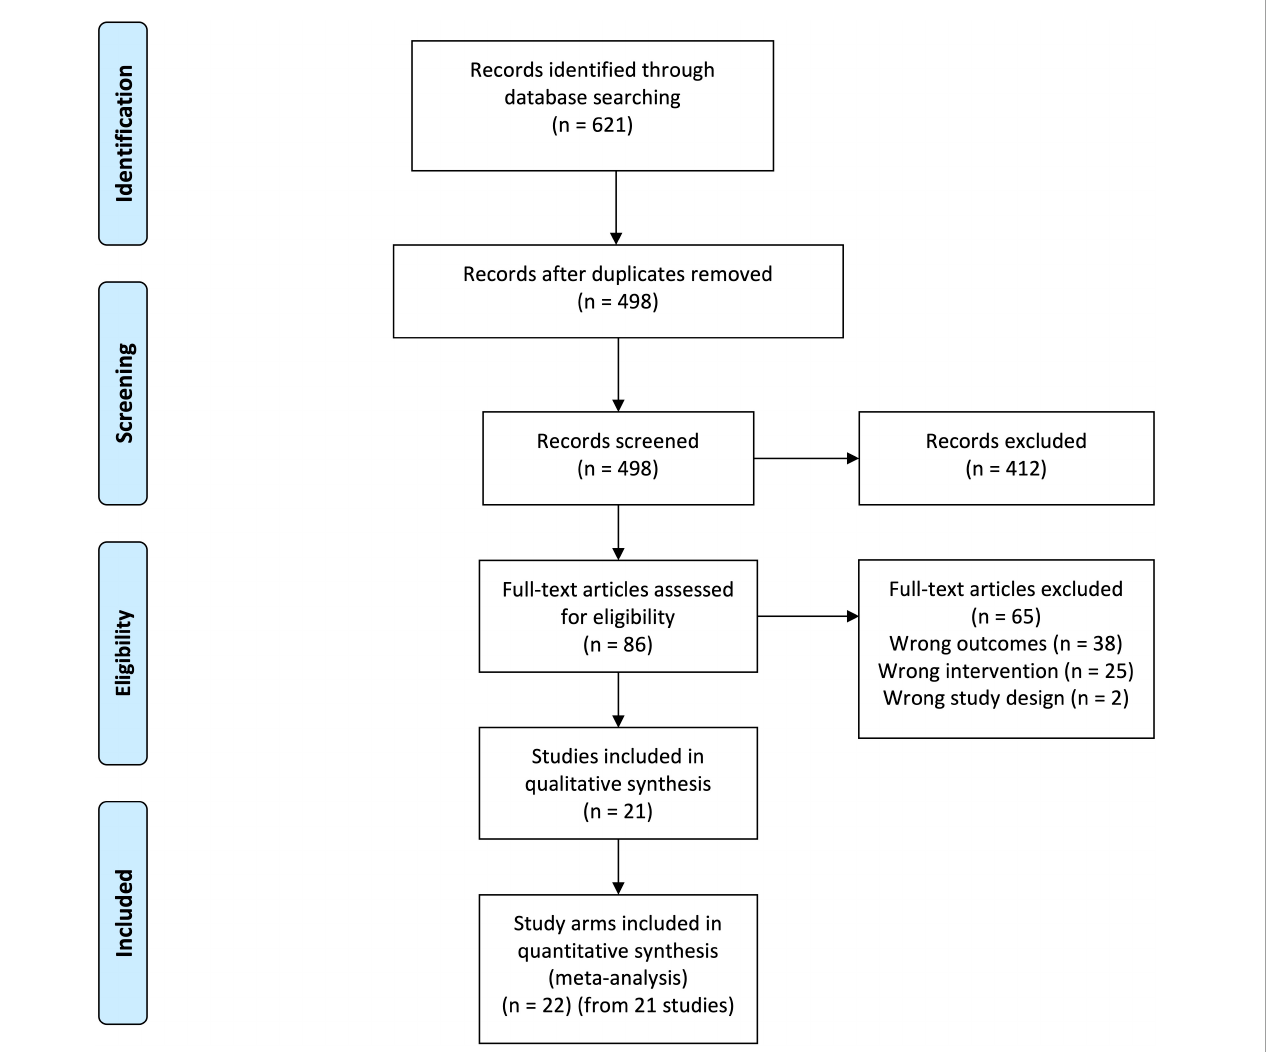
FIGURE1 Preferred reporting items for systematic review and meta-analyses (PRISMA) diagram. From 621 records identified from database searching, 123 were duplicates. Screening of these records at the title and abstract level resulted in the exclusion of 412 records. The 86 remaining records were obtained as full texts and submitted to inclusion and exclusion. This resulted in the exclusion of 65 articles. Twenty-one articles representing 22 study arms from 17 separate randomized controlled trials were included in the final